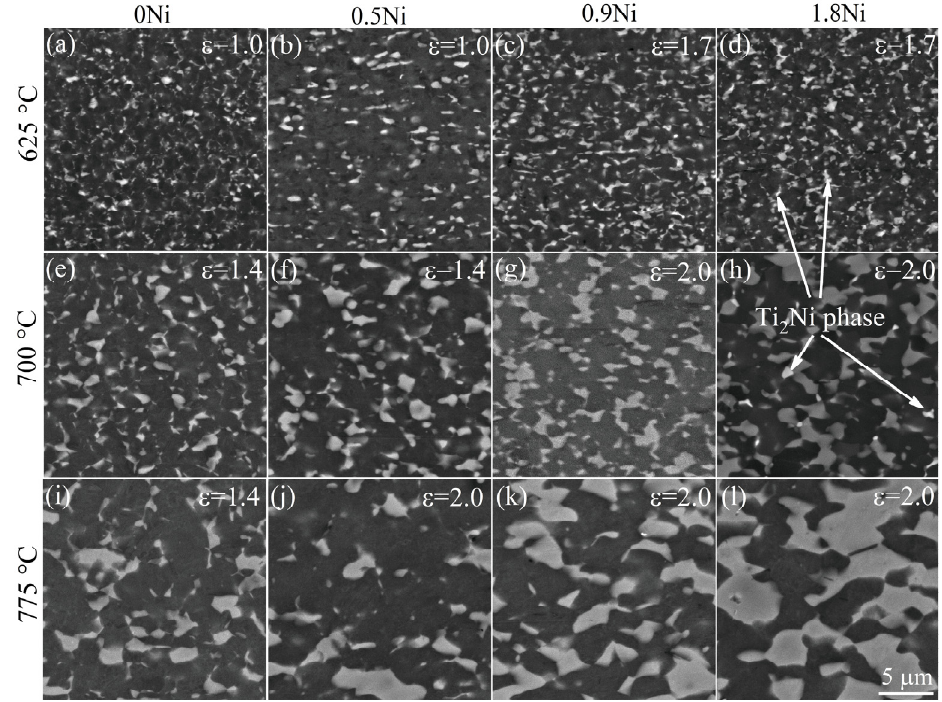
Figure 9. Microstructures of ( a , e , i ) 0Ni, ( b , f , j ) 0.5Ni, ( c , g , k ) 0.9Ni, and ( d , h , l ) 1.8Ni alloys after deformation at 1 × 10 − 3 s − 1 at ( a – c ) 625 °C, ( e – h ) 700 °C, and ( i – l ) 775 °C with different true strains ( ε , indicated on microstructures).